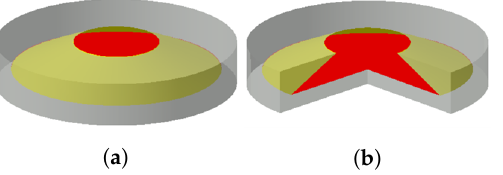
Figure 13. Positive conical cavity model for numerical ray tracing. ( a ) Positive conical cavity (base diameter 154 mm, aperture diameter 45 mm, cavity height 15 mm, external diameter 165 mm, external height 20 mm). ( b ) Positive conical cavity (section view). Red: absorption surfaces, absorptance 85% is selected in this section; Yellow: reflection surface, reflectivity 80%.